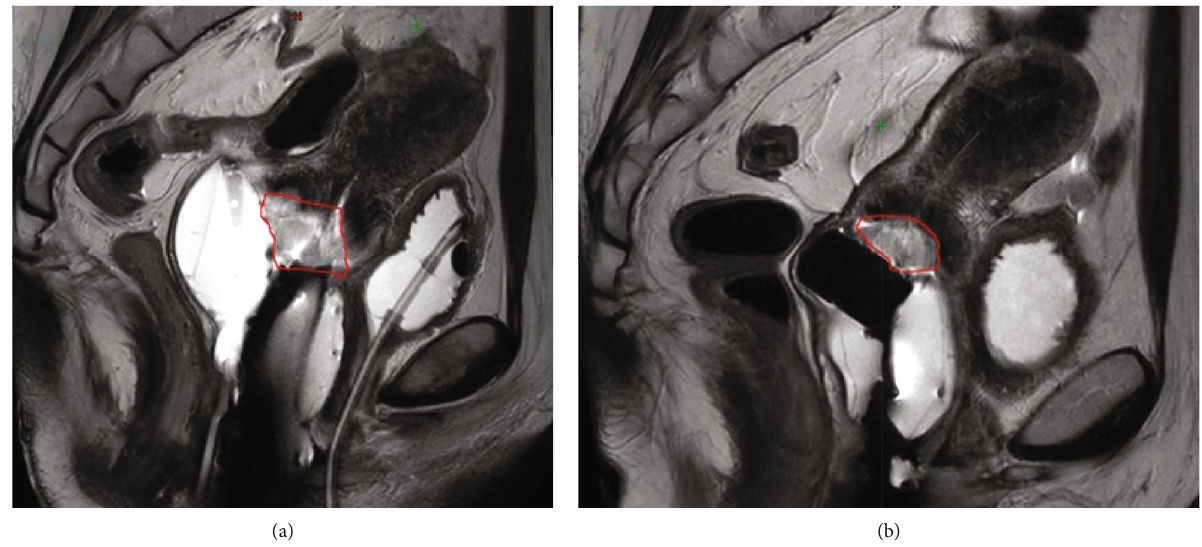
Figure 2: Magnetic resonance image sagittal scan with gross tumor volume (GTV) contours. (a) Fraction 1 with bulky tumor postexternal beam radiotherapy, where GTV was 20.5cm 3 . (b) By fraction 4, there was a signi fi cant tumor response to brachytherapy with a GTV of 4.7cm 3 .